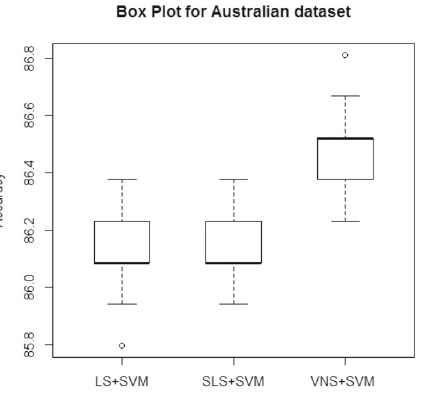
Fig. 3 LS+SVM versus SLS+SVM versus VNS+SVM on German dataset